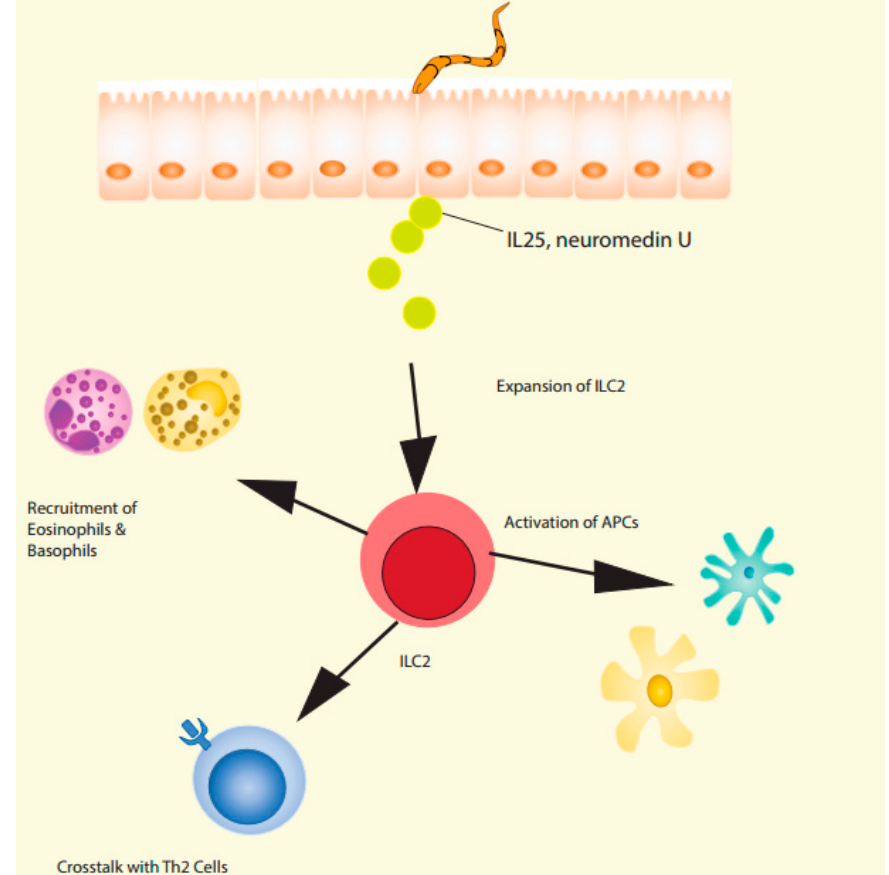
Figure 2. Cytokine circuits of ILC2 in helminth infection.